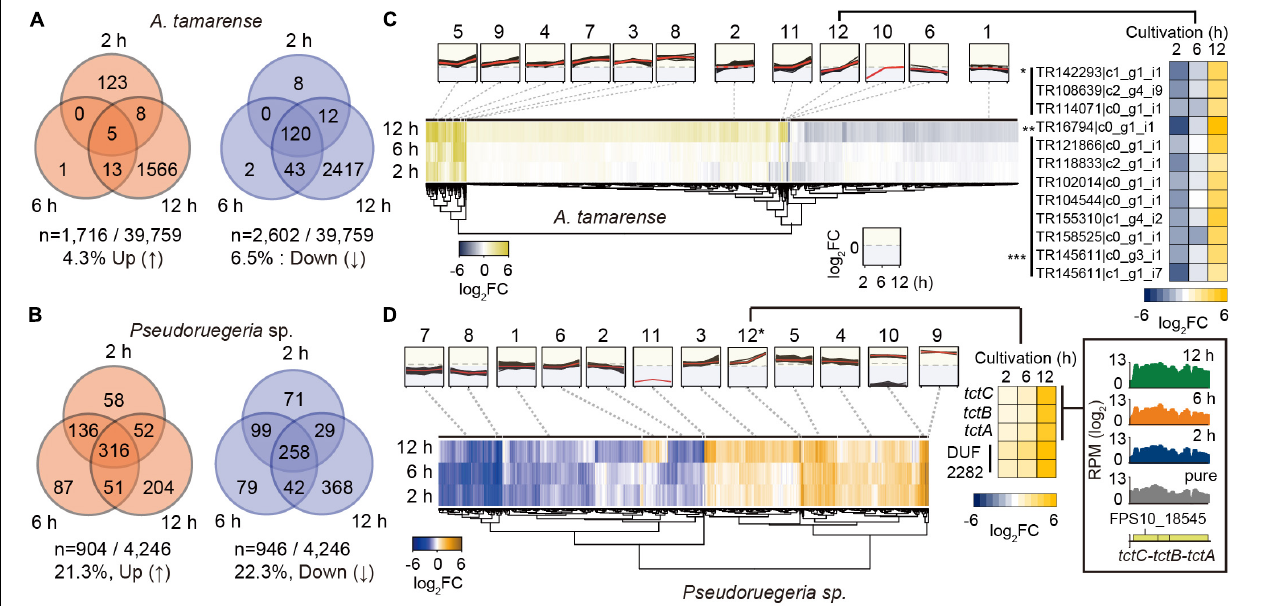
FIGURE 3 | Collection and grouping of differentially expressed genes (DEGs) during the co-culture of A. catenella and Pseudoruegeria sp. (A,B) . The number of upregulated and downregulated genes from the gene dataset satisfying the DEG condition (|log 2 (Normalized RPM coculture /Normalized RPM pure - culture )| ≥ 1 and low p -value (DESeq P < 0.05), reads per million > 50 in pure cells) were counted for A. catenella (A) and Pseudoruegeria sp. (B) according to the co-culture time. (C) DEGs of A. catenella were classified into 12 groups according to the RNA expression profile and are displayed using a heatmap. The RPM fold change of the genes in the 12th group are separately shown using a heatmap. An asterisk (*) indicates cell wall-associated hydrolase- coding genes; double asterisks (**) indicate a putative blue light receptor-coding gene; and triple asterisks (***) indicate uncharacterized protein-coding genes. (D) The DEGs of Pseudoruegeria sp. were also classified into 12 groups according to the RNA expression profile. For example, the tripartite tricarboxylate transporter cluster ( tctC-B-A ) and DUF2282 domain containing membrane protein-coding genes were assigned in the 12th cluster, and their expression fold changes after co-culture are displayed using a heatmap. The expression profiles of the tct gene cluster at the pure-culture and co-cultures for 2, 6, and 12 h are displayed using